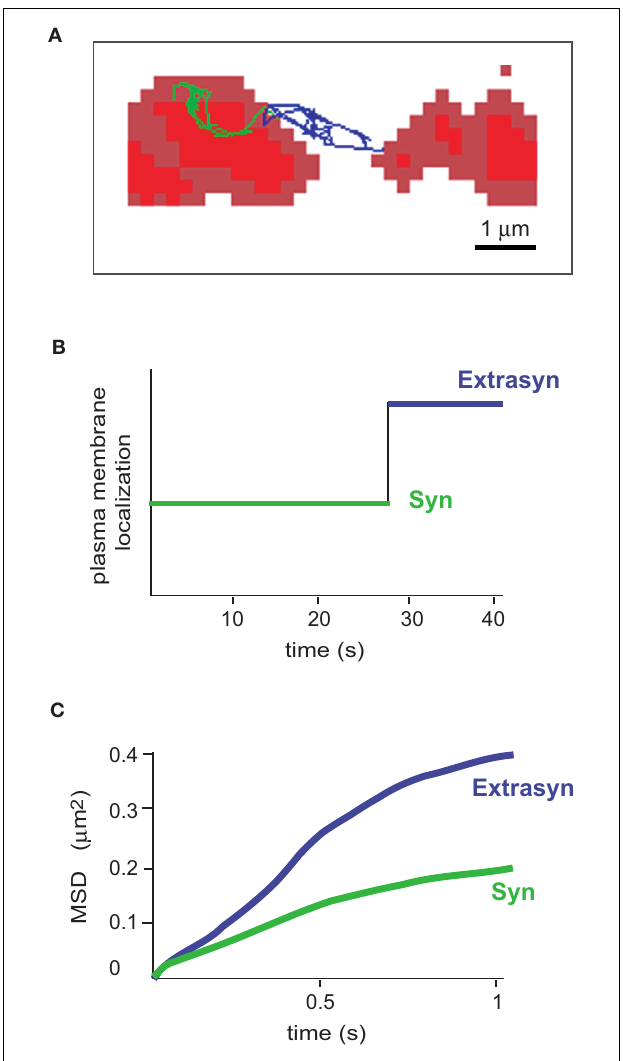
FIGURE 4 | Diffusion properties of the glycine receptor. (A) Example of an individual GlyR-QDot trajectory exchanging between a synaptic (trace in green) and an extrasynaptic location (trace in blue). FM4-64-stained synapses are in red. (B) Time spent by the GlyR-QDot in the different compartments over a 40-s recording (same colour code). (C) Time-averaged MSD function of the QDot shown in (A) . The two curves represent synaptic (green) and extrasynaptic (blue) portions of the trajectory. Curves are typical of confi ned (negatively bent) and free-diffusing molecules,